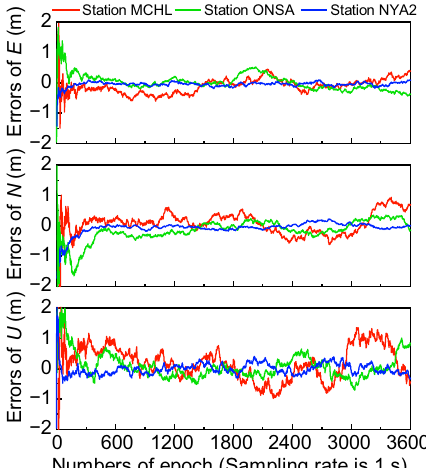
Fig. 11 Results of kinematic Doppler positioning solutions in the east (E), north (N) and up (U) directions, respectively, at station MCHL, ONSA and NYA2 for scheme 1